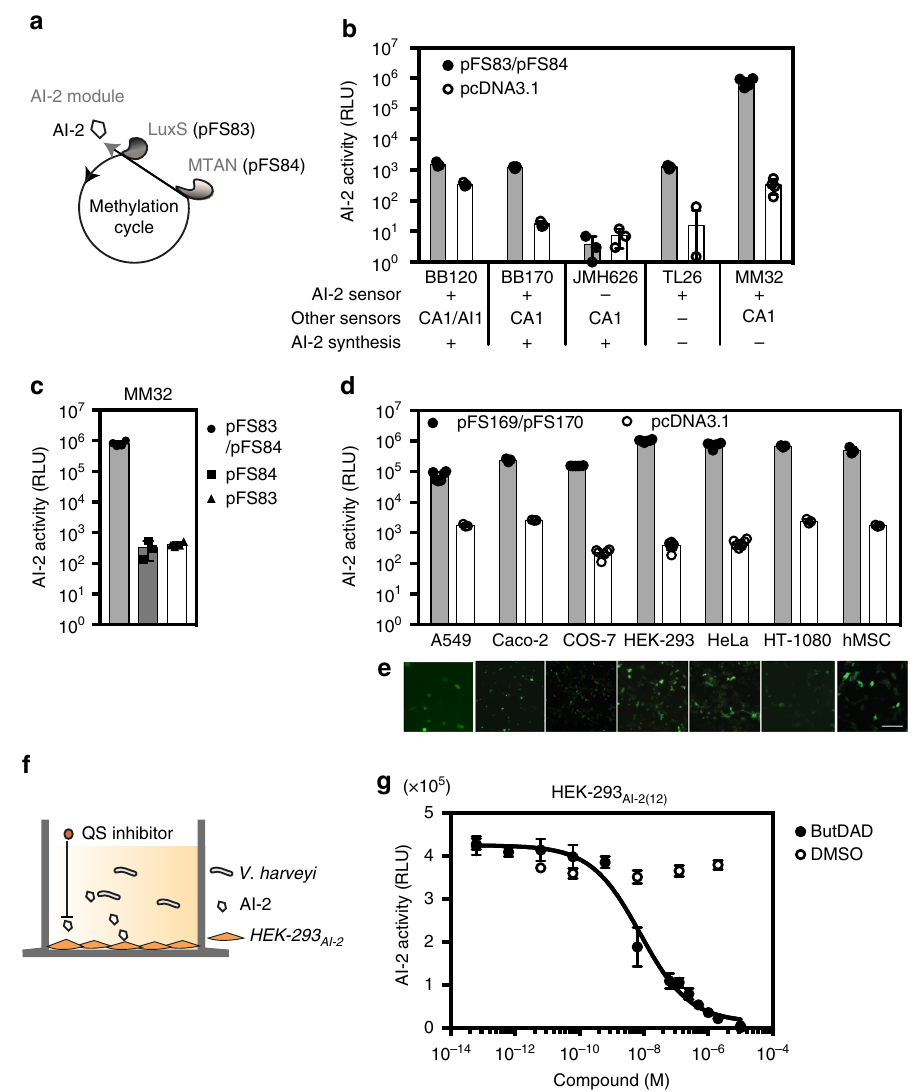
Fig. 4 Validation of arti fi cial human autoinducer-2 synthesis. a Schematic representation of the methylation cycle by-pass for continuous AI-2 biosynthesis. b Bioluminescence of V. harveyi strains showing distinct sensor properties in response to supernatants of AI-2 module-engineered HEK-293 cells. Cells co- transfected with LuxS (P hCMV -LuxS-pA, pFS83) and MTAN (P hCMV -MTAN-pA, pFS84) or pcDNA3.1-transfected were cultivated for 24 h before